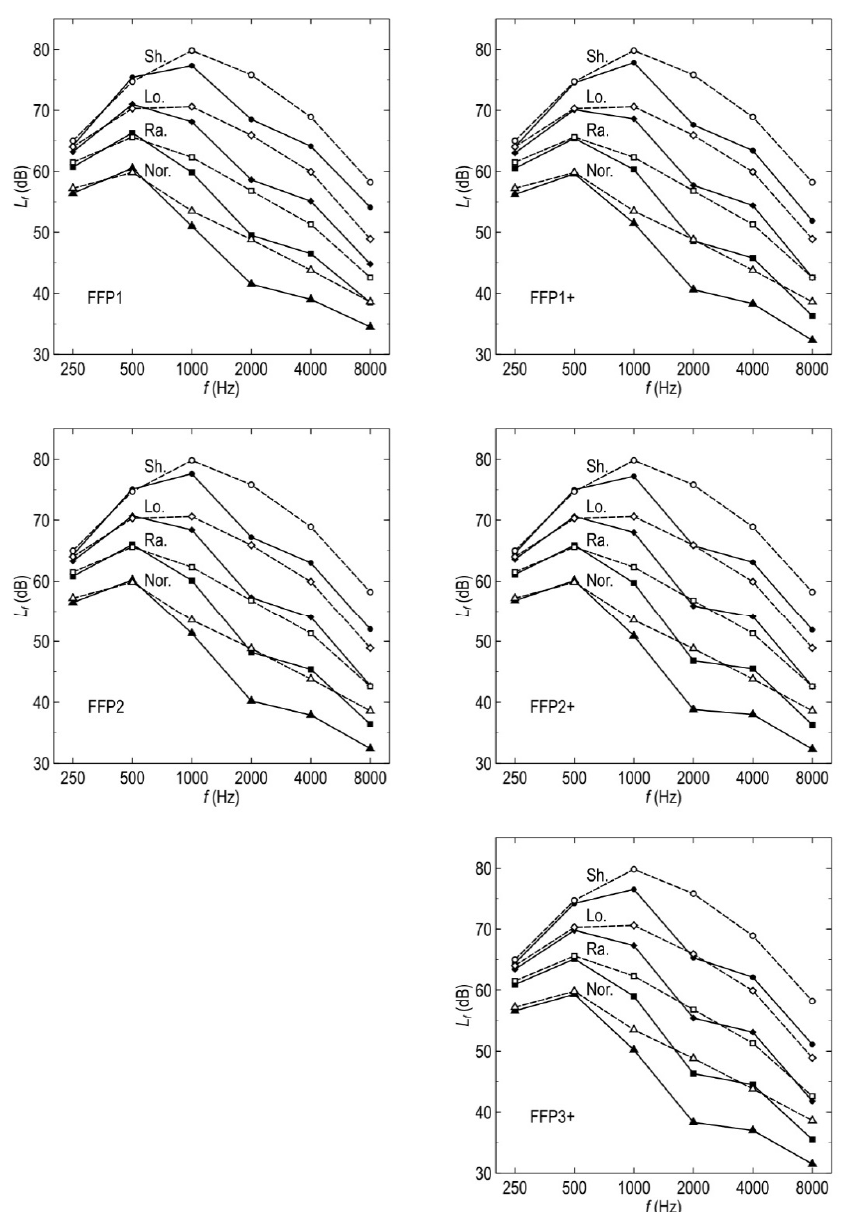
Figure 6. Disruptions caused by FFPs on the ANSI speech spectra. Empty symbols—ANSI spectra, filled symbols—spectra with the FFPs corrections: L f (ANSI)— ∆ L f ,60s . Lines are guides for the eye only. Speech levels: Nor.—normal, Ra.—raised, Lo.—loud, Sh.—shouted. Plus sign in the FFP symbol denotes a mask with an exhalation